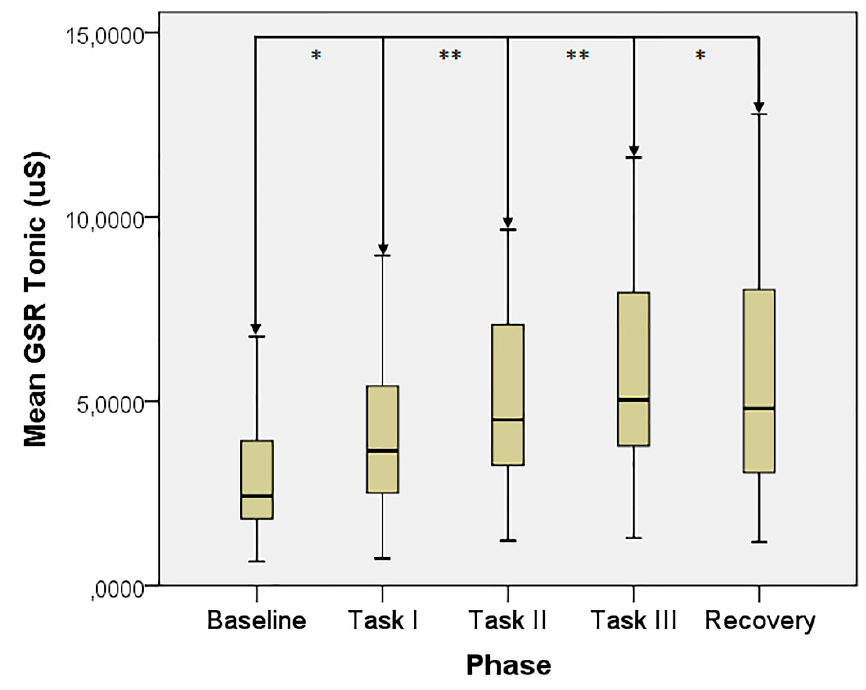
Figure 2. GSR tonic value across the test phases. *: p < 0.05, **: p < 0.01.